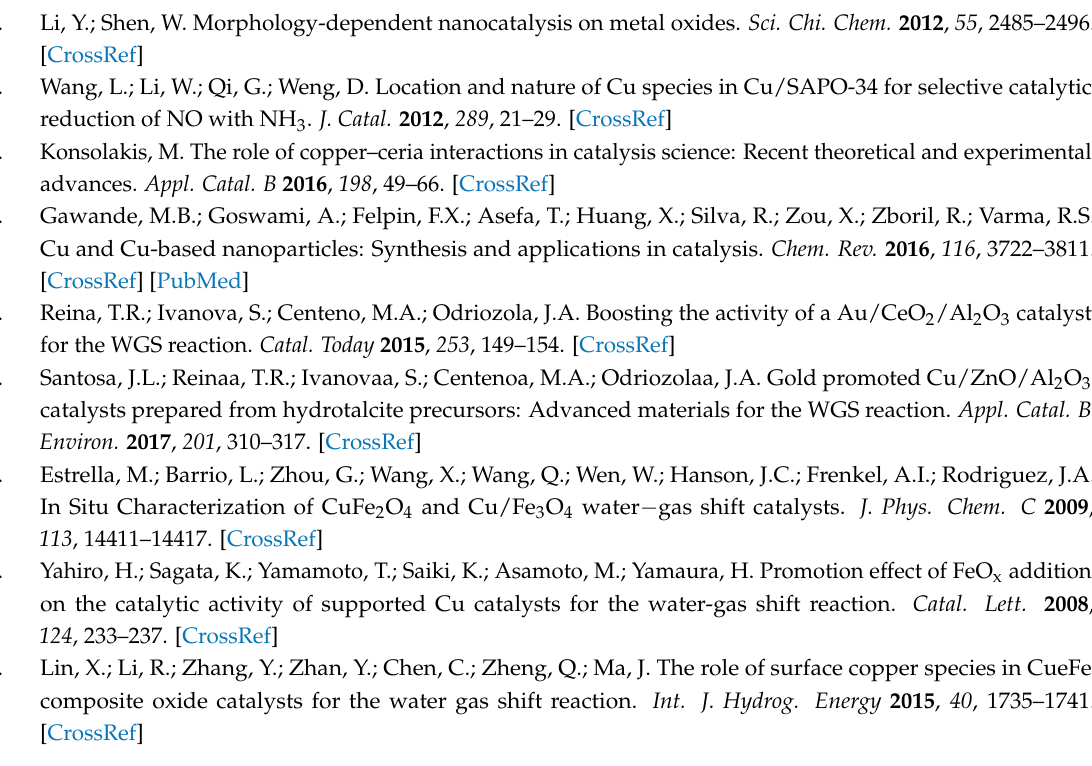
Figure S1: XRD profile (a) and HRTEM image (b) of used